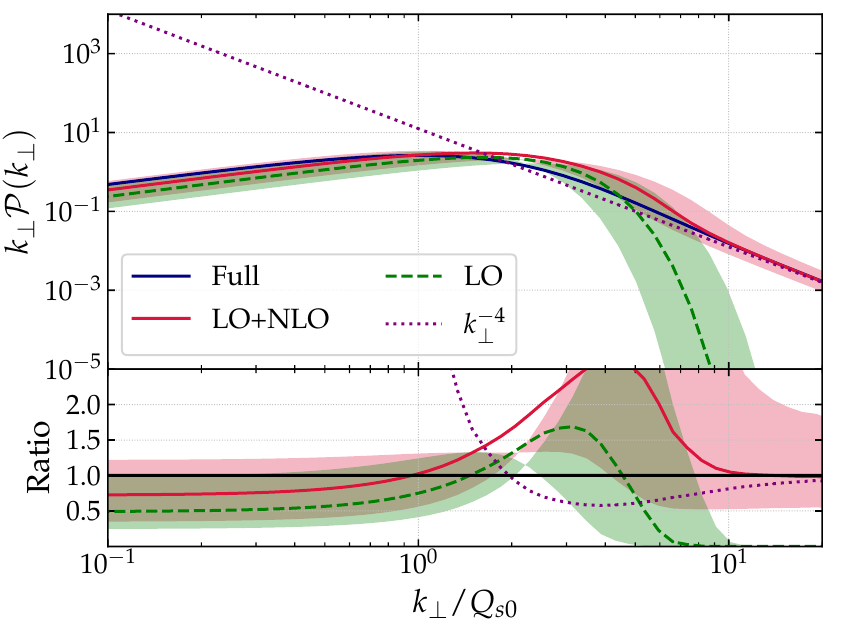
Figure 1 . Comparison between the broadening probability distribution for the IOE at LO (dashed, green), at LO+NLO (solid, red) and the exact GW model result (solid, navy). In addition, we provide the single hard scattering solution given by eq. (2.21), which we denote by k − 4 purple). The ratio to the full solution is presented in the bottom panels. The uncertainty band arises from variations in the matching scale by factors of 2 and 1 / 2 . The medium parameters are ˆ q 0 =0 . 16 GeV 3 , L = 6 fm and µ ∗ = 0 . 355 GeV. They are identical to the ones used in section